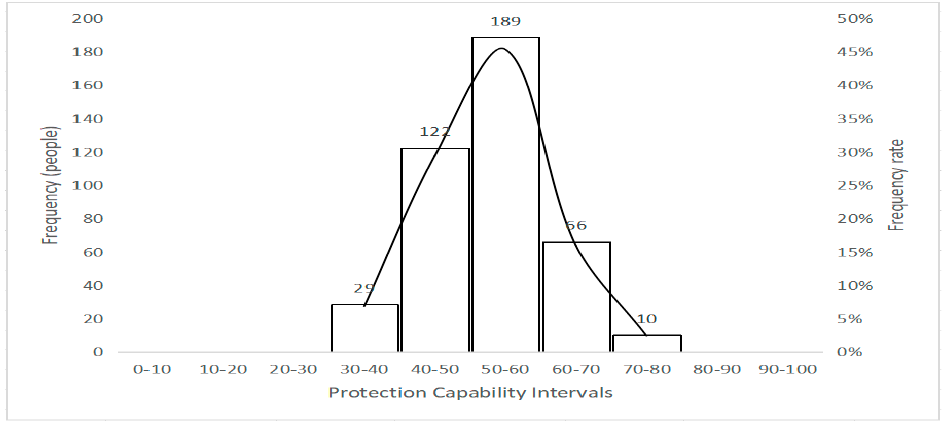
Figure 8. Frequency histogram of privacy protection capability.